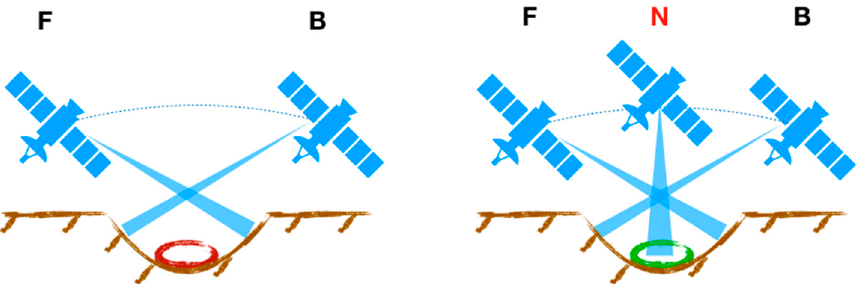
Figure 1. Stereoscopic cover capabilities over the studied surfaces with deep morphological depres- sions: on the left, the red region represents the area that cannot be covered by the standard stereo images; on the right, the nadir image allows to complete the visualization of the steep walls and the floor of the depression (in green).